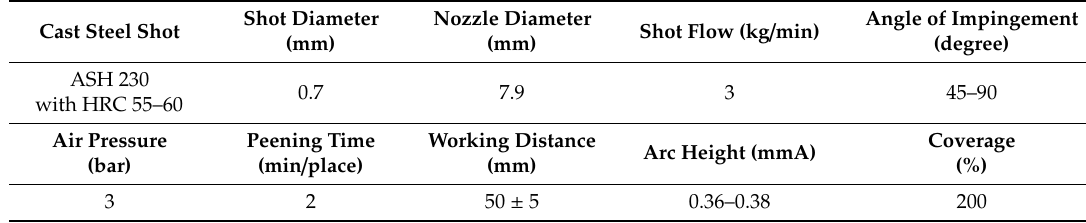
Table 2. Shot peening (SP) conditions.